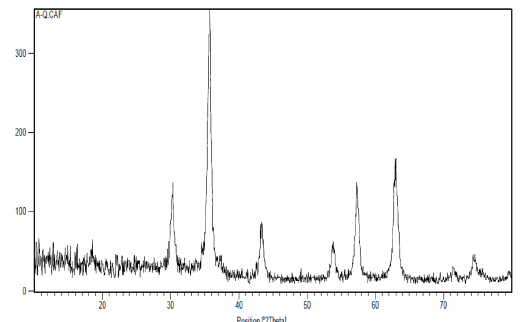
O nanoparticles Fig. 2. Magnetic hysteresis curves of Fe 3 O 4 3 4